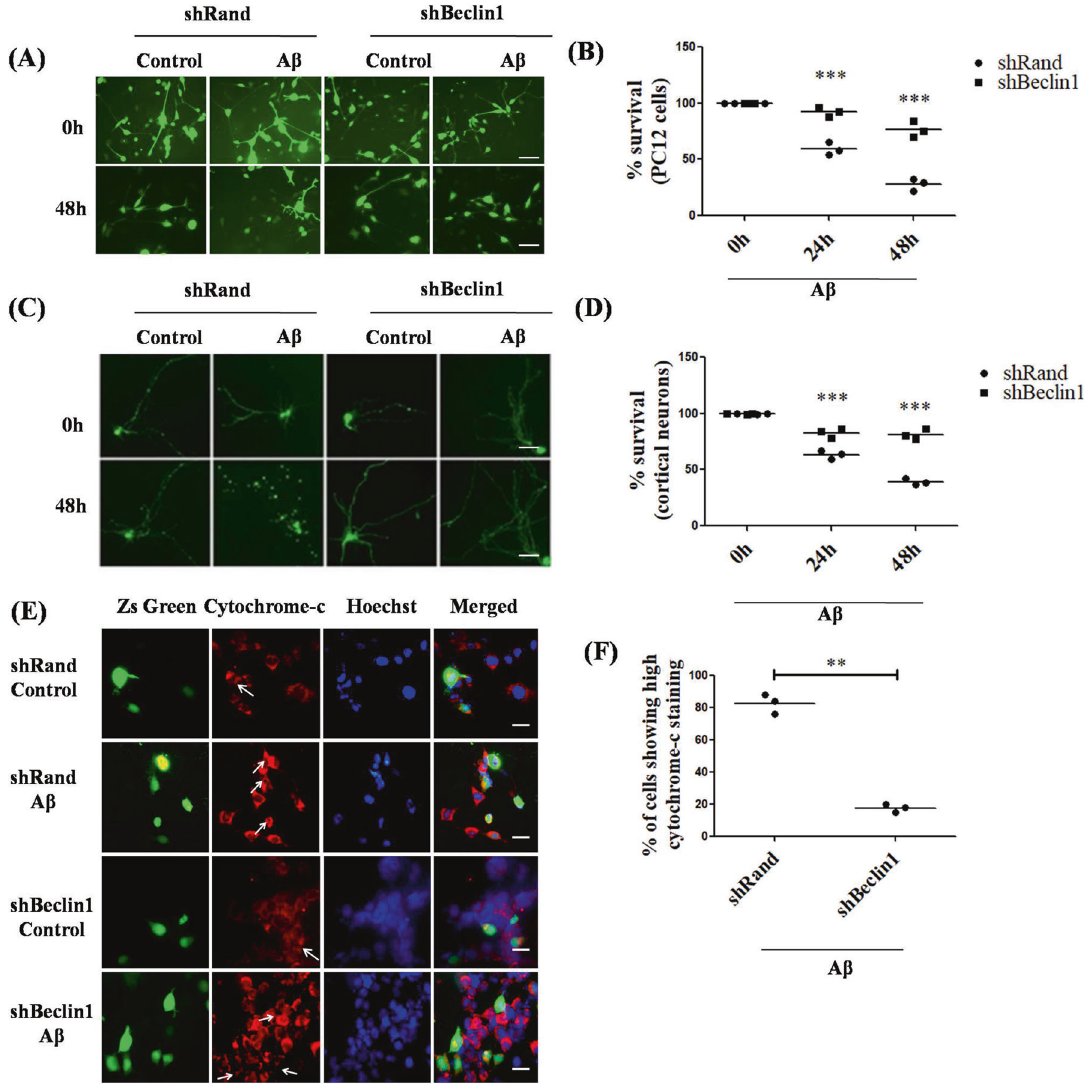
Fig. 4 Downregulating Beclin1 protects neuronal cells against A β treatment. ( A ) Neuronally differentiated PC12 cells were transfected with shBeclin1-ZsGreen or shRand-ZsGreen. 48 h post transfection, cells were treated with 5 µM A β . Representative images of transfected cells that were maintained in the presence or absence of A β for indicated time periods are shown. Scale bars: 50 µm. ( B ) Graphical representation of the percentage of viable cells where live green cells were counted just after treatment and after 48 h of treatment with A β under a fl uorescence microscope. Data represented were collected from 3 independent experiments. ( C ) Primary cultured rat cortical neurons (3 DIV) were transfected with shBeclin1-ZsGreen or control shRand-ZsGreen and maintained for 48 h and then subjected to 1.5 µM A β for 48 h. Representative pictures of transfected neurons that were maintained in the presence or absence of A β for indicated time periods are shown. Images were taken using an inverted fl uorescence microscope. Scale bars: 50 µm. ( D ) Graphical representation of the percentage of viable green cells after each time point. The numbers of surviving transfected (green) cells were counted under a fl uorescence microscope just after treatment and after 48 h of treatment with A β . Data represented were collected from 3 independent experiments. ( E ) Neuronal PC12 cells were transfected with shBeclin1-ZsGreen or shRand-ZsGreen. 48 h post-transfection, cells were treated with A β and immunostained for cytochrome-c and checked under a fl uorescence microscope. Scale bars: 50 µm. ( F ) Graphical representation of the percentage of cells with high cytochrome-c staining after A β treatment in Beclin1 downregulated conditions. Data represented were collected from 3 independent experiments. The asterisks denote statistically signi fi cant differences from control (shRand) at corresponding time points or conditions; ** p < 0.001, *** p <